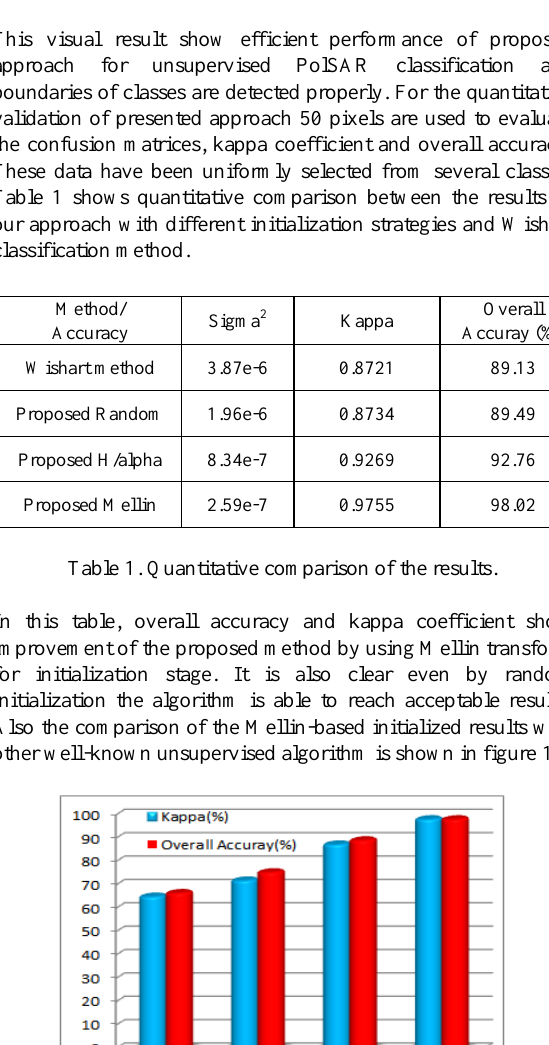
Figure 6. Random initialization of proposed method. Second method for initialization is based on H/alpha classification map. Entropy and alpha parameters of selected sub-sample are shown in figure 7.